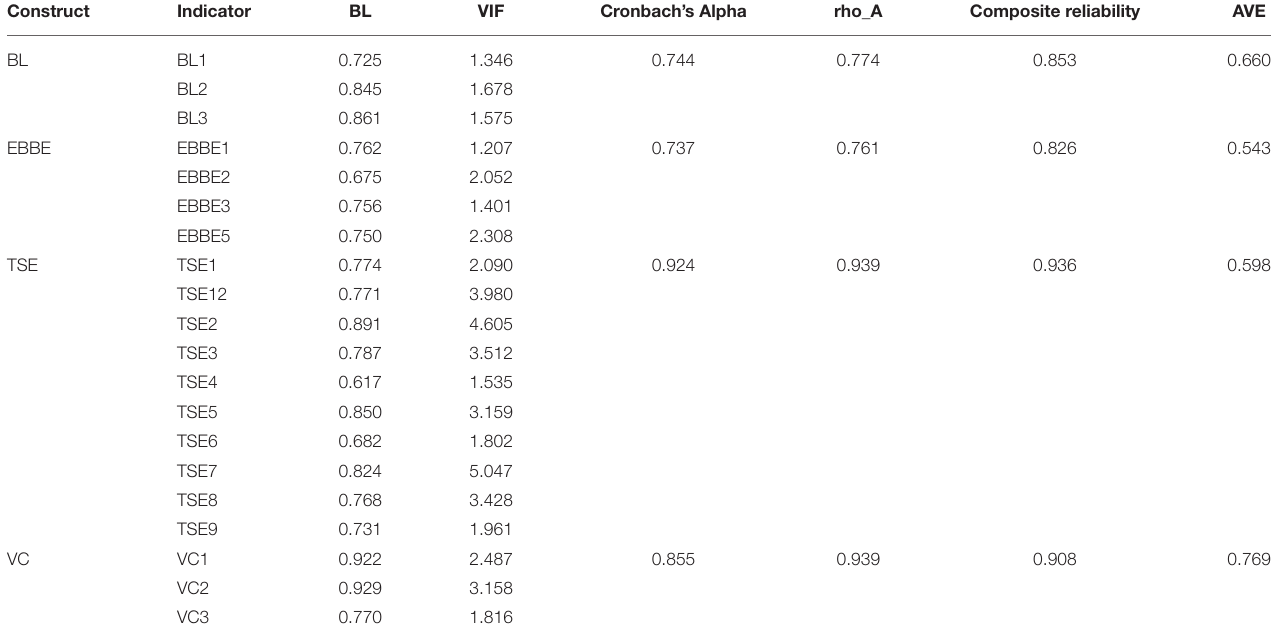
TABLE 2 | Reliability and convergent validity of the study constructs. Construct